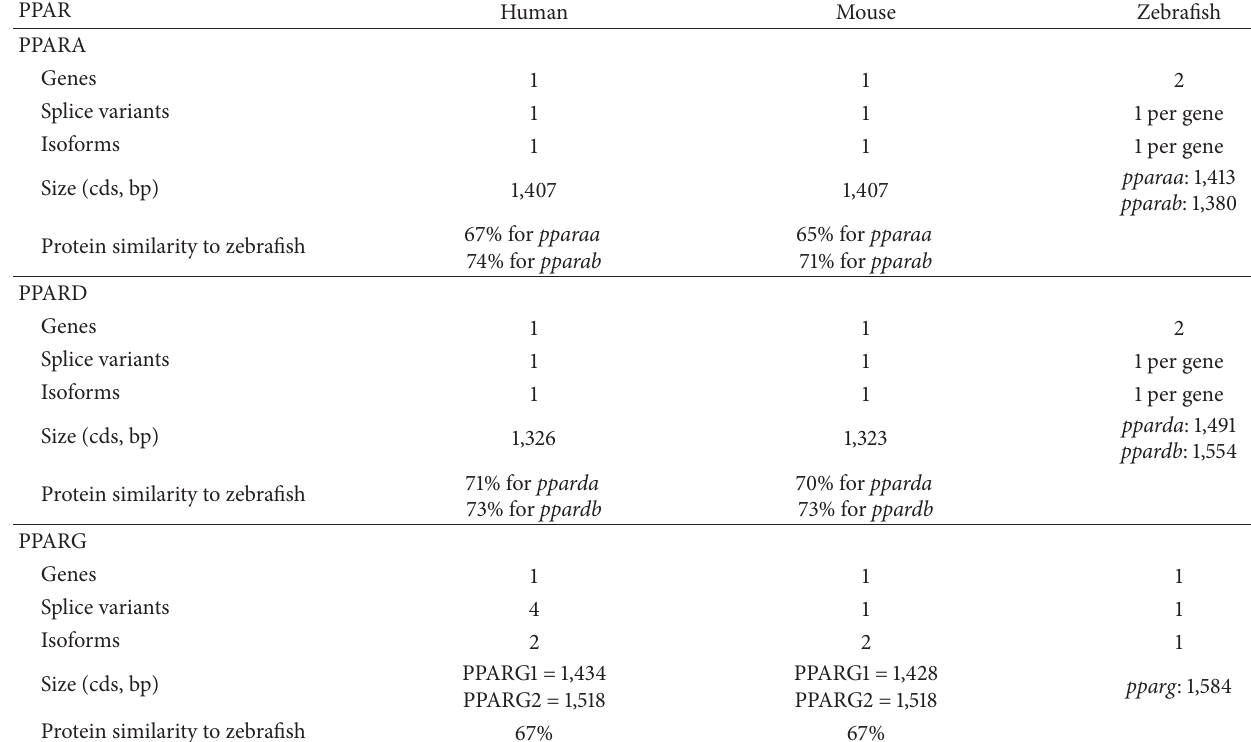
Table 3: Comparison of PPARs between human, mouse, and